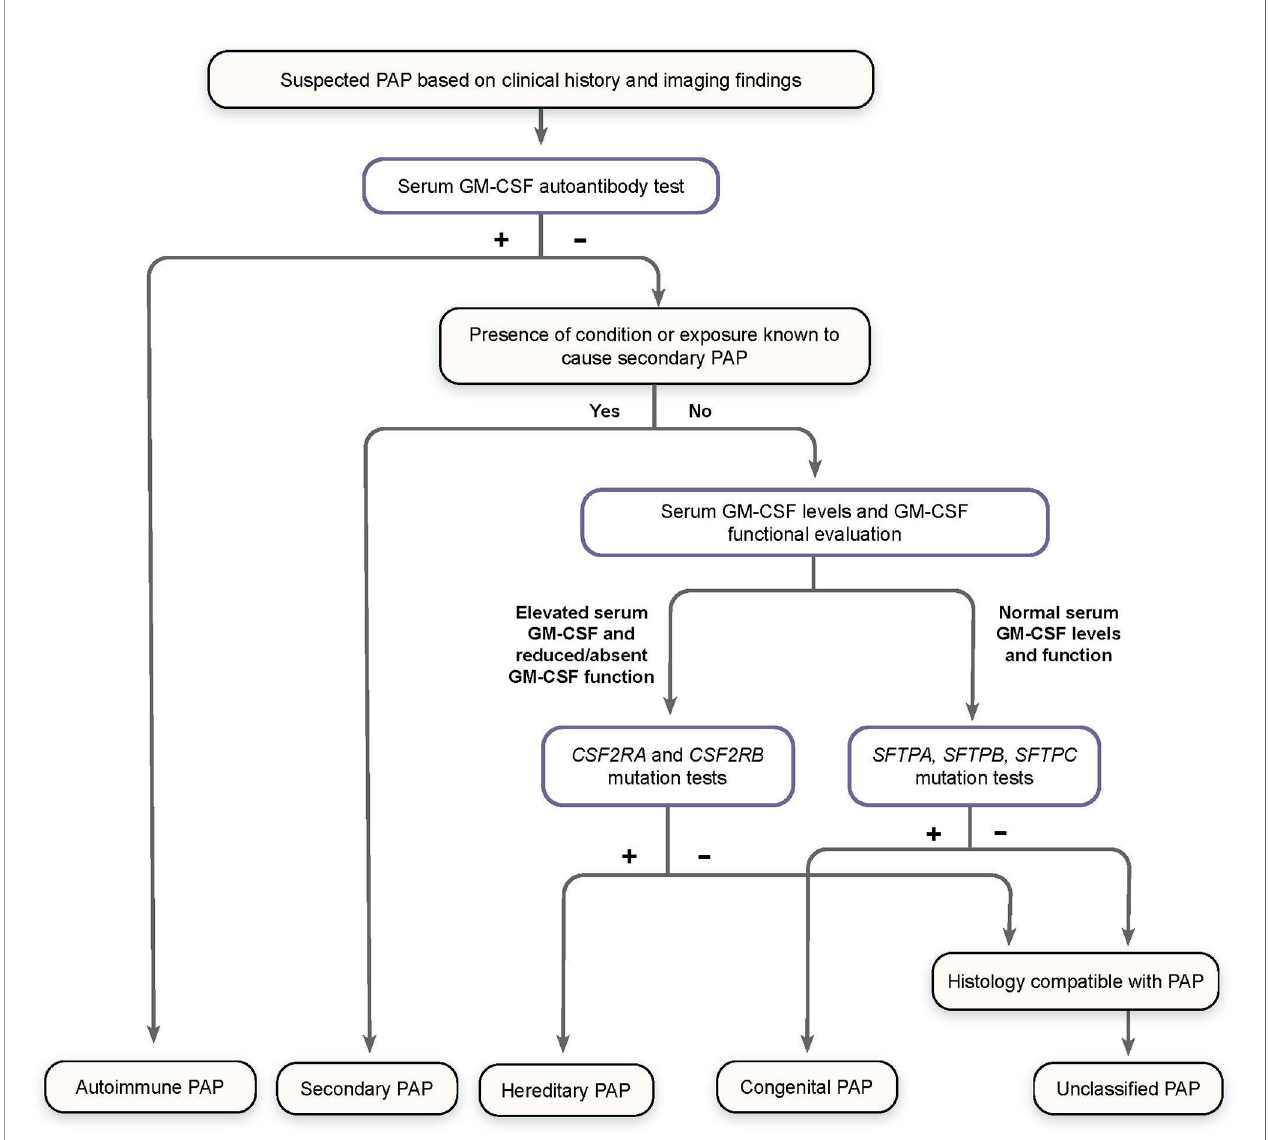
FIGURE 3 | Algorithm for Diagnosis of Pulmonary Alveolar Proteinosis (PAP). Patients suspected of having PAP on the basis of clinical history and imaging fi ndings should undergo screening for serum GM-CSF autoantibodies. Elevated autoantibody levels con fi rm a diagnosis of autoimmune PAP. Patients with a known condition or exposure associated with secondary PAP who do not have increased GM-CSF autoantibodies are diagnosed accordingly. Otherwise, patients should be screened for serum GM-CSF levels and GM-CSF function signaling by fl ow cytometry, as well as genomic analysis for mutations affecting GM-CSF receptor genes ( CSF2RA and CSF2RB) and those related to surfactant production ( SFTPA, SFTPB, SFTPC) , to con fi rm a diagnosis of hereditary, congenital, or unclassi fi ed PAP, all of which are exceedingly rare. (Adapted from “ Pulmonary alveolar proteinosis, ” by BC Trapnell, 2019, Nat Rev Dis Primers, 5:16:8.